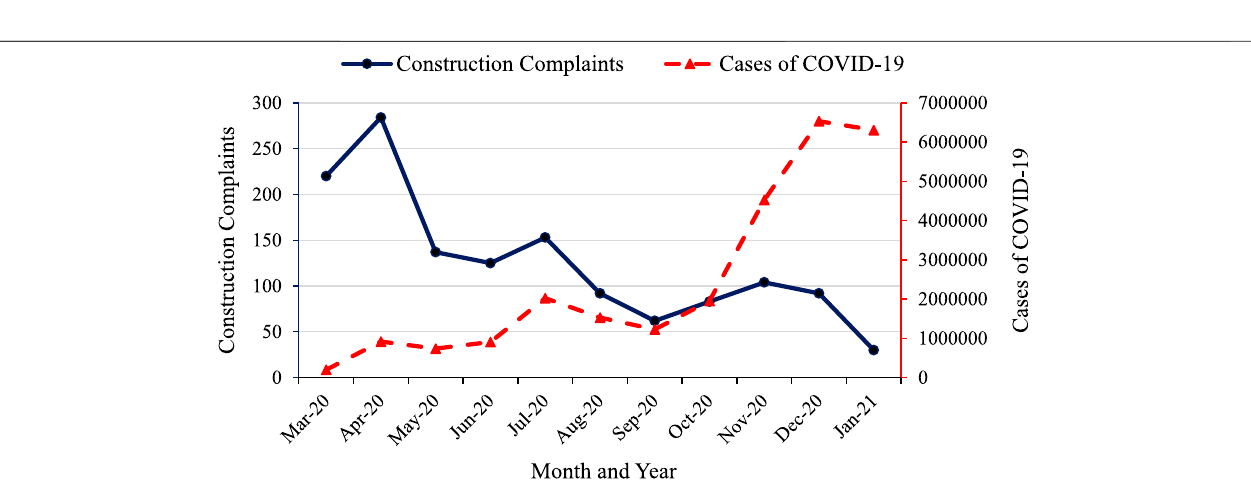
Frontiers in Built Environment |